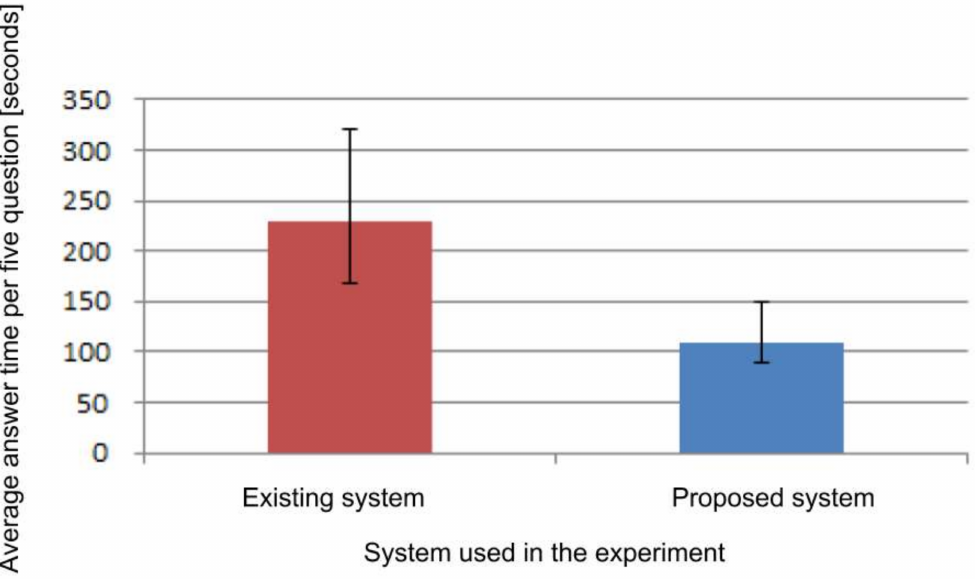
Figure 17. Average time taken to answer five questions on one event in Experiment